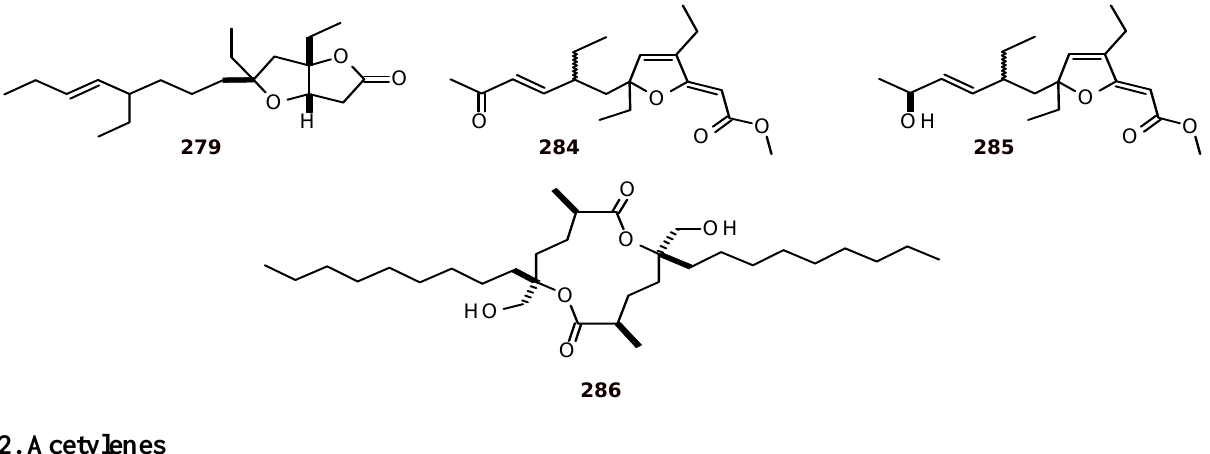
Figure 35. Structures of other polyketides 279 and 284 - 286 from